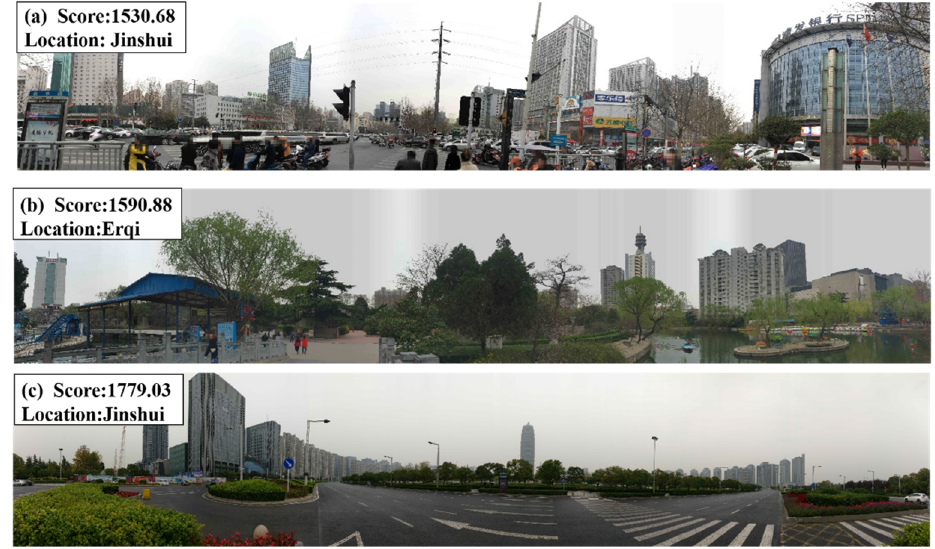
Figure 4. Typical panoramic pictures. ( a ), ( b ), and ( c ) were collected in Jinshui, Erqi, and Jinshui, respectively.